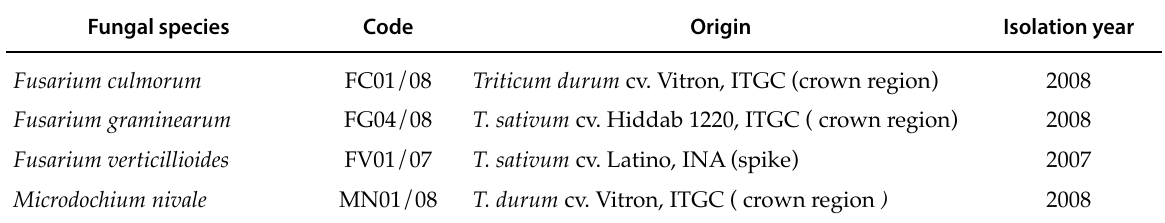
Table 2. List and origin of fungal phytopathogens used in this study. Fungal